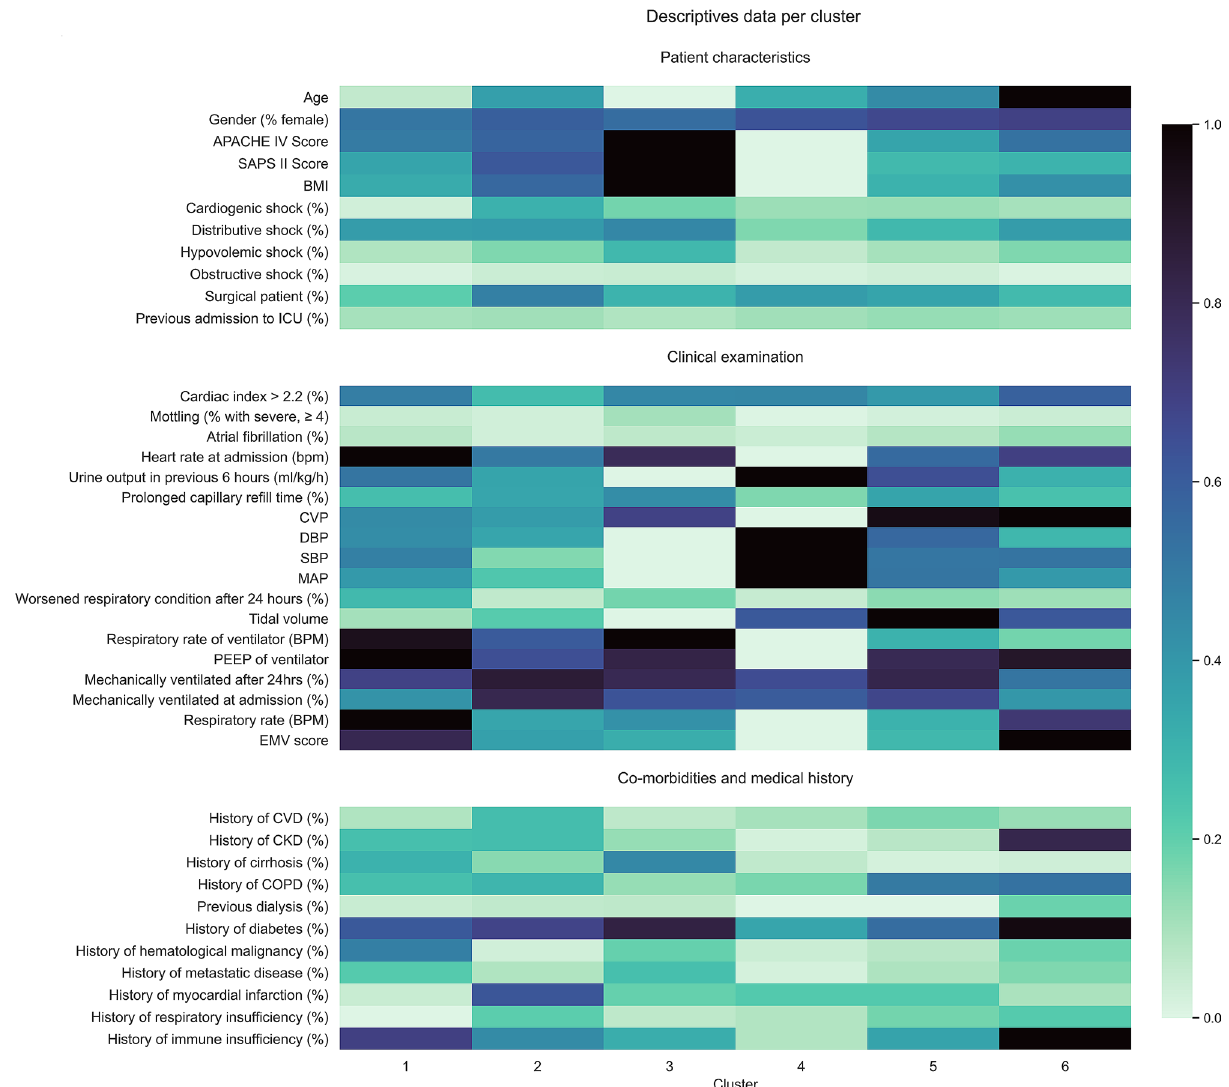
Figure 2. Heatmap of patient characteristics, clinical examination and co-morbidity data per cluster. Bars on the right show the colour scale representing the proportion of patients with each characteristic regarding demographics, clinical examination, and co-morbidities. For continuous variables, such as SBP or urine output, it represents a scaled value from highest cluster mean (1.0) to lowest cluster mean Cluster 2 (n = 100) included the highest percentage of surgical patients (48%, Fig. 2, Supplementary Table S3), including the largest post-transplant group, and cardiac and vascular procedures (Fig. 3, Supplementary Table S6). Almost 40% of patients presented with acute or chronic cardiac condition, with 63% having a low cardiac index (Fig. 3, Supplementary Table S6). Accordingly, troponin T, lactate dehydrogenase (LDH), creatine kinase (CK) and inflammatory variables were increased (Fig. 2, Supplementary Table S4, Supplementary Fig. S9). Patients in this cluster had higher mortality rates (ICU, 30-day, and 90-day; HR 1.55 [95% CI 1.26–1.91], 1.39 [1.12–1.71], and 1.30 [1.06–1.61], respectively) and were at increased risk of stage 2 or 3 acute kidney injury (HR 1.26 [95% CI 1.03–1.59]) (Fig. 3, Table 3, Supplementary Table S6). Higher values for arterial oxygen (pO 2 ), LDH, lactate, troponin and calcium were associated with cluster membership, while low pO 2 , LDH, and ASAT values drove predictions towards non-membership (Supplementary Fig. S13). Cluster 3 (n = 46) consisted of patients with diverse disease etiology, from liver disease and transplant (24%), to cardiac arrest (11%), sepsis (10%) and respiratory failure (10%). These patients were the youngest and had the highest severity scores at admission (Fig. 2, Supplementary Table S3). Like cluster 2, laboratory variables showed significant elevated troponin T, LDH, CK and inflammatory values (Fig. 2, Supplementary Table S4 and Supplementary Fig. S10). During clinical examination, this group recorded the lowest urine output values (0.58 ml/kg/h), 43% had delayed capillary refill time, and 11% had severe mottling (Fig. 2, Supplementary Table S3). Almost 35% of patients required renal replacement therapy (RRT), and 91% developed AKI, with a HR of stage 2 or 3 AKI of 1.67 [95% CI 1.24–2.25]. These patients also needed the highest vasopressor dose, and had